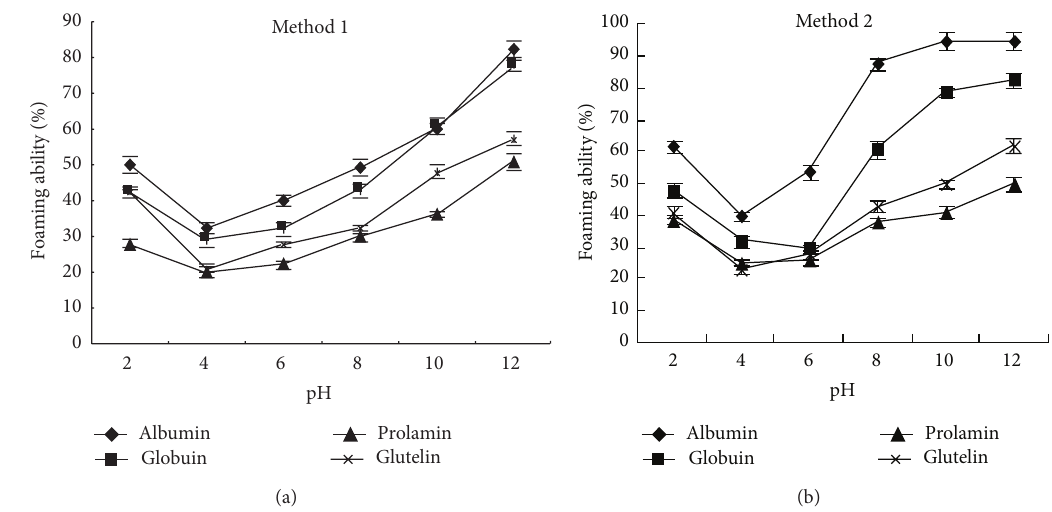
Figure 4: Foam properties at different pH levels of FRBPs prepared by the two extraction methods.